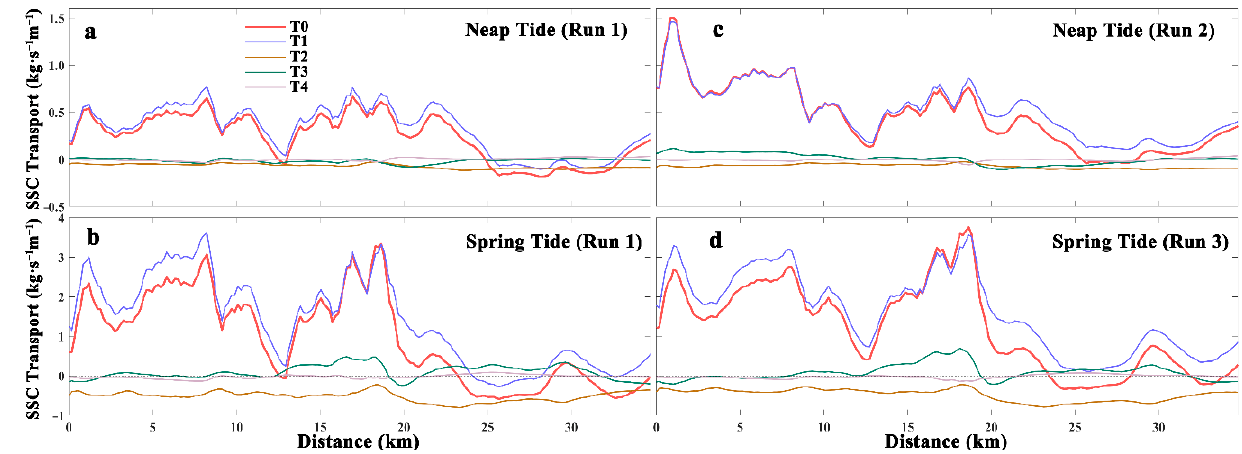
Figure 12. Tidally averaged SSC transport and its decomposed terms on the along-channel section under ( a , b ) the low- discharge condition and ( c , d ) PRD condition. Upper panels are during neap tide, and lower panels are during spring tide. Positive value means seaward transport.